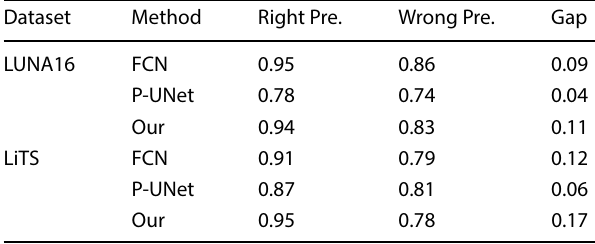
Table 3 Uncertainty gap accumulated with three methods in differ- ent network structures in LUNA16 and LiTS challenge